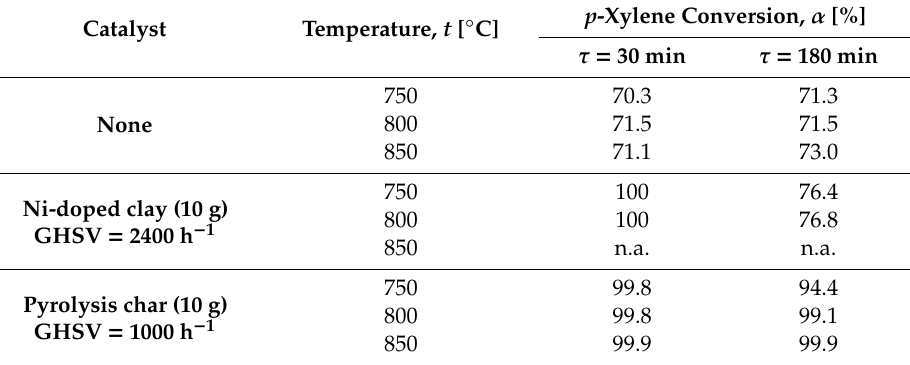
Table 3. Variation of p -xylene conversion and selectivity to toluene with reaction temperature, presence of catalysts and reaction time.